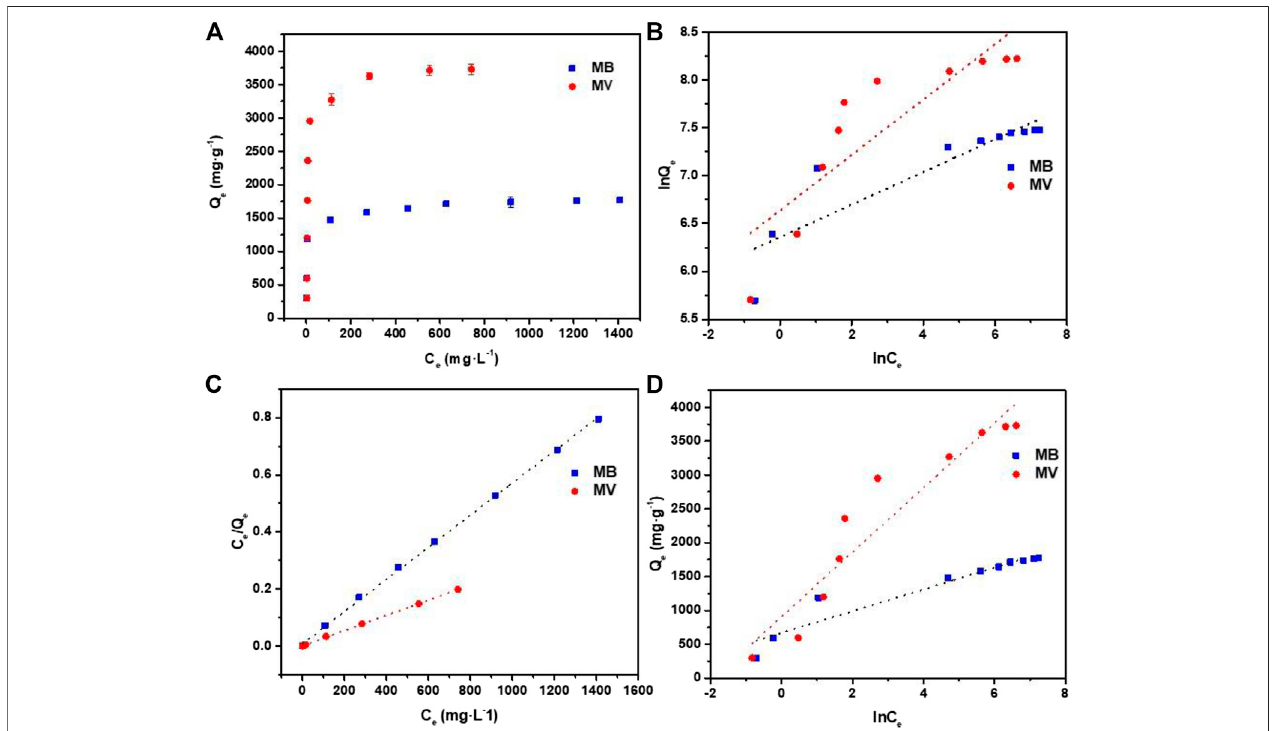
FIGURE6|(A) Adsorption isothermsfor theadsorption ofMB and MVbyPFPCSat pH (cid:2) 8and 25 ° C. (B) Freundlich isotherm model plots. (C) Langmuirisotherm model plots. (D) Temkin model plots.